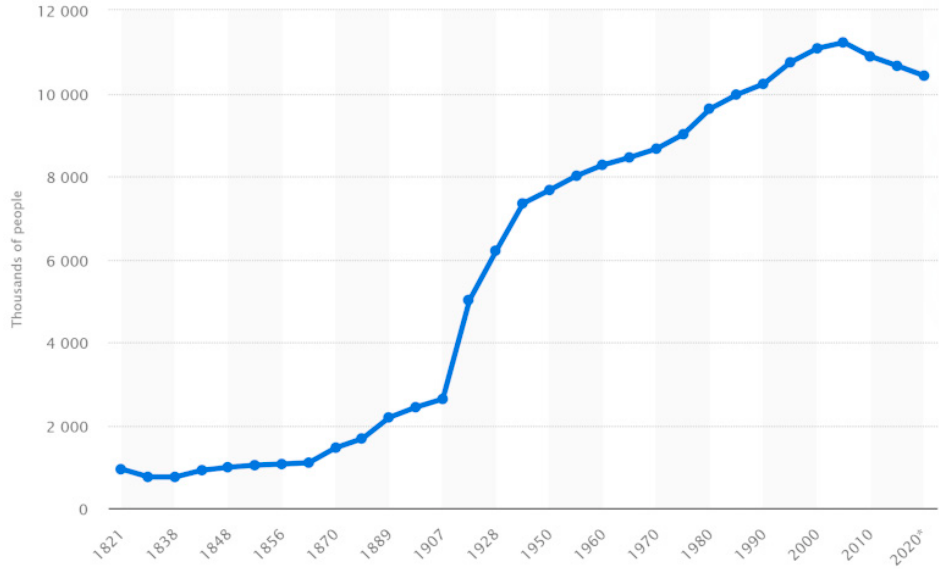
Figure 2. Total population growth since the unification of the Greek state (* 2020 estimate).